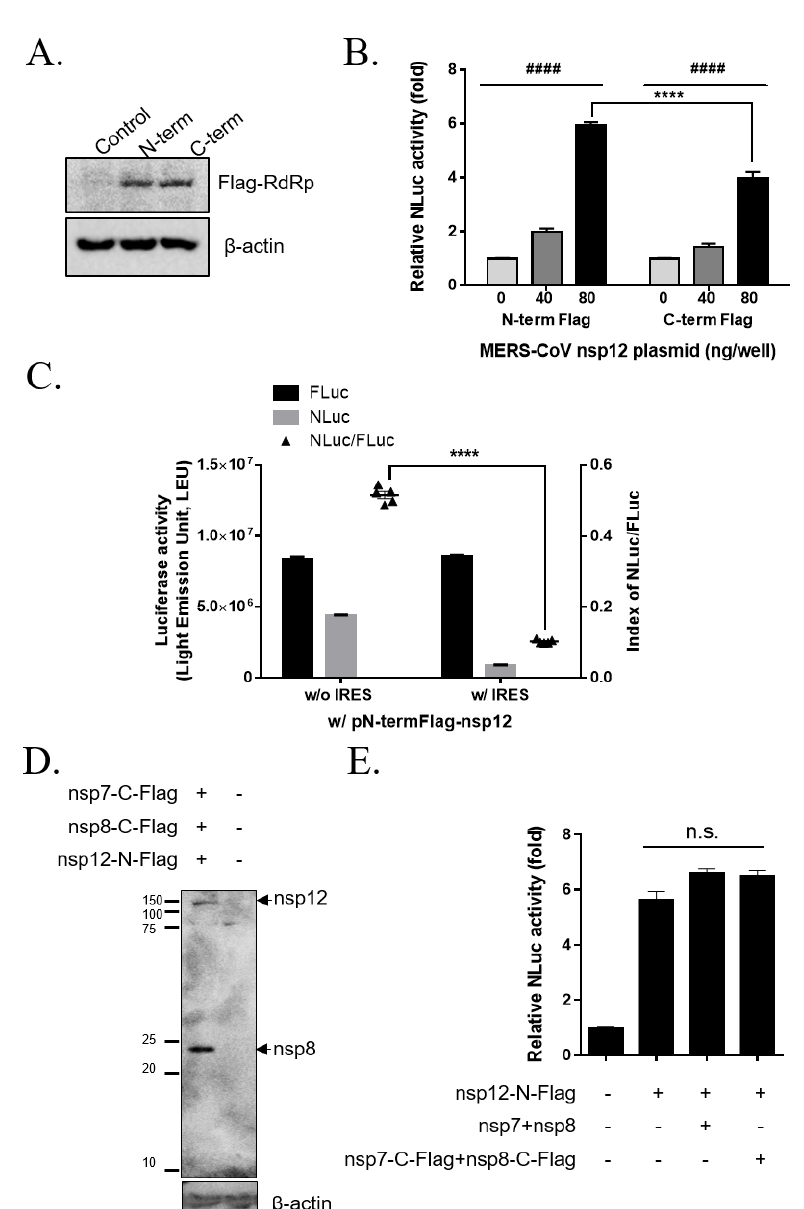
Figure 2. Confirmation of the expression and activity of Middle East respiratory syndrome coronavirus (MERS-CoV) RNA-dependent RNA polymerase (RdRp). ( A ) Expression of the N-terminal (N-term) or C-terminal (C-term) FLAG-tagged MERS-CoV RdRp. HEK293T cells were transfected with pN-termFlag-nsp12 or pC-termFlag-nsp12 plasmids for 24 h. N-term and C-term Flag-tagged RdRp protein was detected as a 110-kDa band via western blotting. β -actin was used as a loading control. ( B ) Comparison of N-term and C-term 110-kDa MERS-CoV RdRp protein activity. HEK293T cells were transfected with 0, 40, or 80 ng of pN-termFlag-nsp12 (N-term) or pC-termFlag-nsp12 (C-term) plasmids together with p ( + )FLuc-( − )UTR-NLuc. After 24 h, FLuc and NLuc activities were detected using the Nano-glo ® Dual-Luciferase ® Reporter Assay System, and the relative NLuc activity was normalized by the FLuc activity. (n = 3; flag-tag e ff ect, F 1,12 = 51.55, p < 0.0001; plasmid dose e ff ect, F 2,12 = 429.7, p < 0.0001; flag-tag times plasmid dose interaction, F 2,12 = 25.12, p < 0.0001; N-term 80